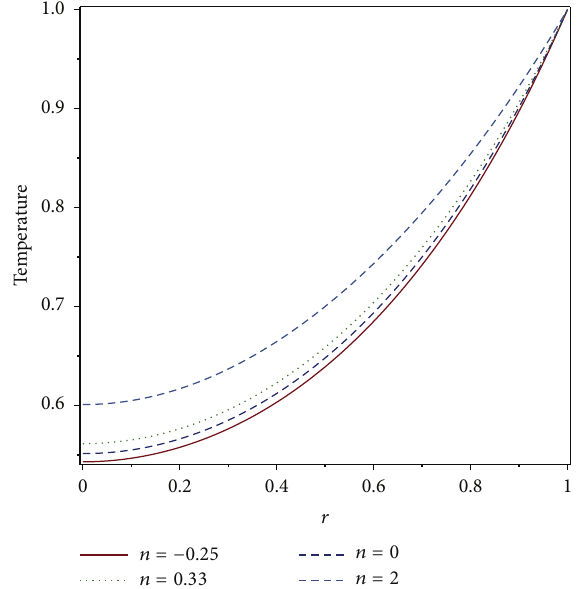
Figure 7: Temperature profile given solutions (20) for varying values of 𝑛 . Here 𝑀 = 2 is